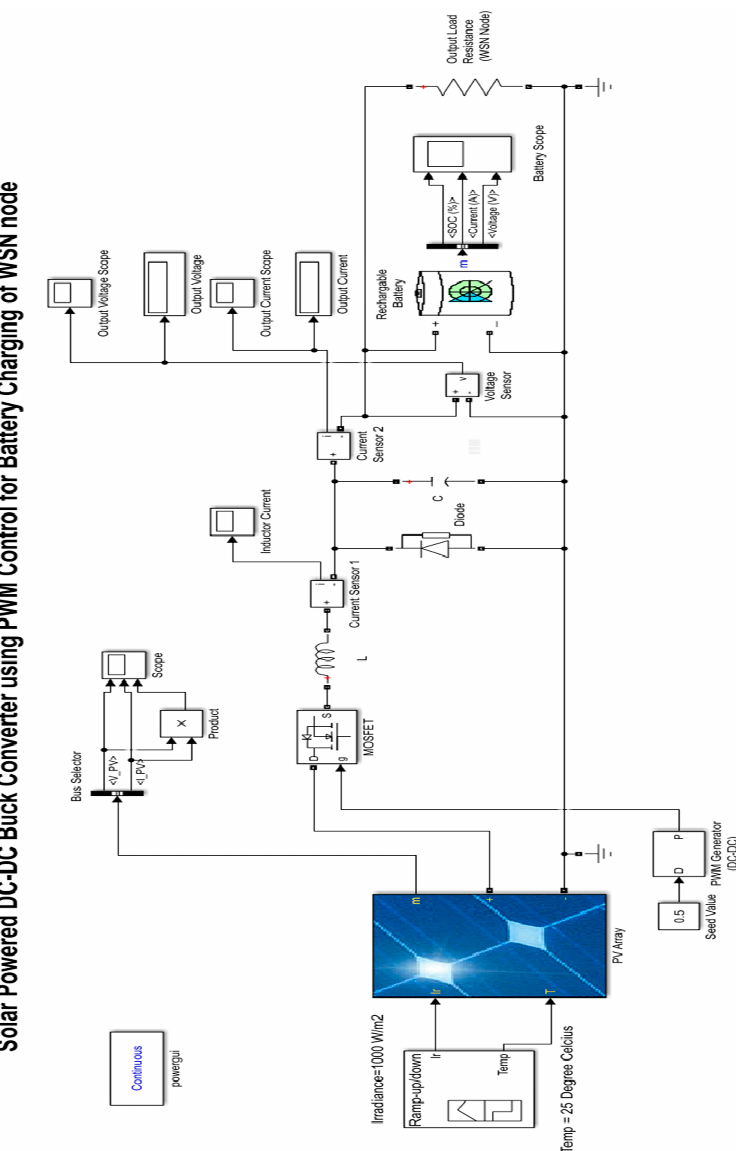
Figure 8. MATLAB/SIMULINK model for PWM controlled solar energy harvesting (SEH) system for WSN Node.